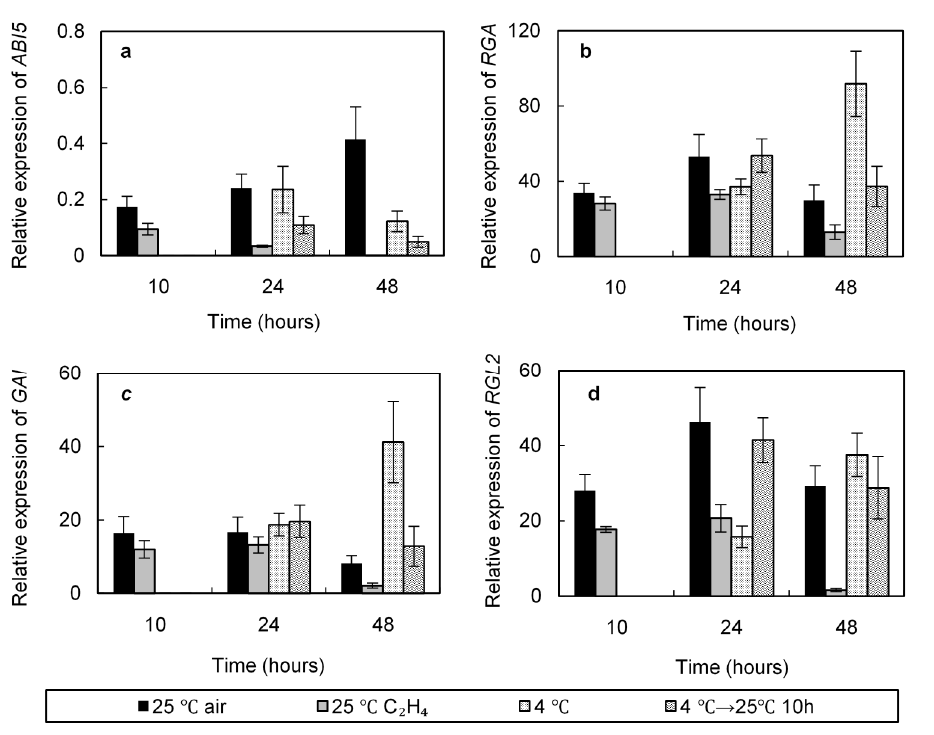
Figure 6. Relative expression of ABI5 ( a ), RGA ( b ), GAI ( c ), and RGL2 ( d ) in seeds (Col-0) incubated at 25 °C or at 4 °C on water, at 25 °C for 10 h after stratification at 4 °C and at 25 °C in the presence of ethylene 100 ppm. An arbitrary value of 1 was assigned to dry seeds. Means of three replicates ± SD. Seeds harvested in 2016.